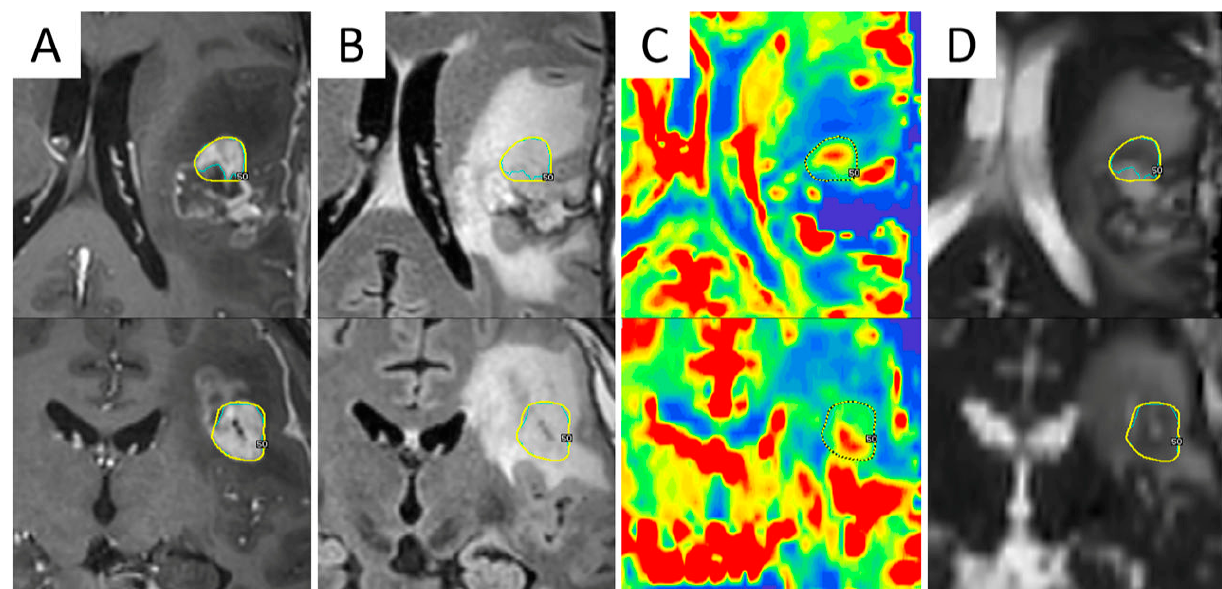
Figure 2. Integration of advanced MRI sequences in a Gamma Knife radiosurgical planning of a 44-year-old male patient with recurrent WHO grade III astrocytoma after multimodal first-line therapy and recent redo surgery with maximum safe resection. Axial (upper row) and coronal (bottom row) views of contrast-enhanced T1-weighted ( A ) and fluid-attenuated inversion recovery (FLAIR) ( B ) MRI images, co-registered with relative cerebral blood volume (rCBV) map ( C ) and apparent diffusion coefficient (ADC) map ( D ), demonstrating how different sequences identify different volumes of disease. The final target was determined as the nodule showing hyper-intensity in post-contrast T1-weighted sequences, hypo-intensity in ADC maps, and elevated perfusion values on the rCBV map.